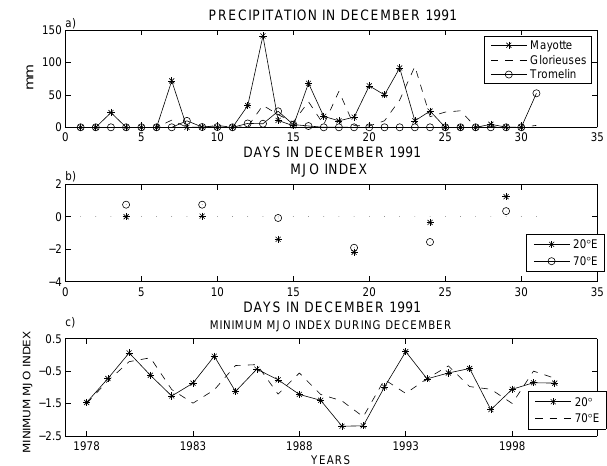
Figure 9. Time series of (a) precipitation in December 1991 for the Glorieuses, Mayotte and Tromelin and (b) the MJO index at 20 and 70 ◦ E. Pentad MJO indices for 1991 are derived from extended empirical orthogonal function (EEOF) analysis applied to pen- tad 200hPa velocity potential (CHI200) anomalies equatorward of 30 ◦ N during ENSO-neutral and weak ENSO winters (November– April). (c) Minimum of MJO index observed each year during De-